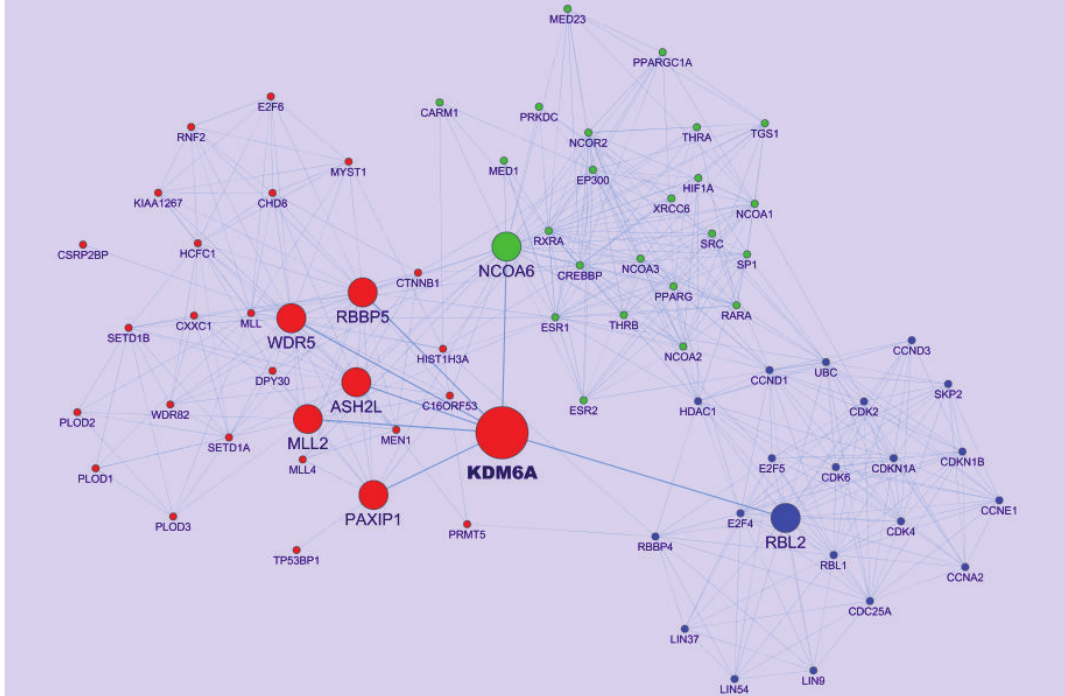
Figure 1: PPI network derived from KDM6A. KDM6A has seven direct neighbors tagged with middle node size. There are three clusters, whose nodes are distinguished with different colors (cluster 1: red; cluster 2: green; cluster 3: blue).